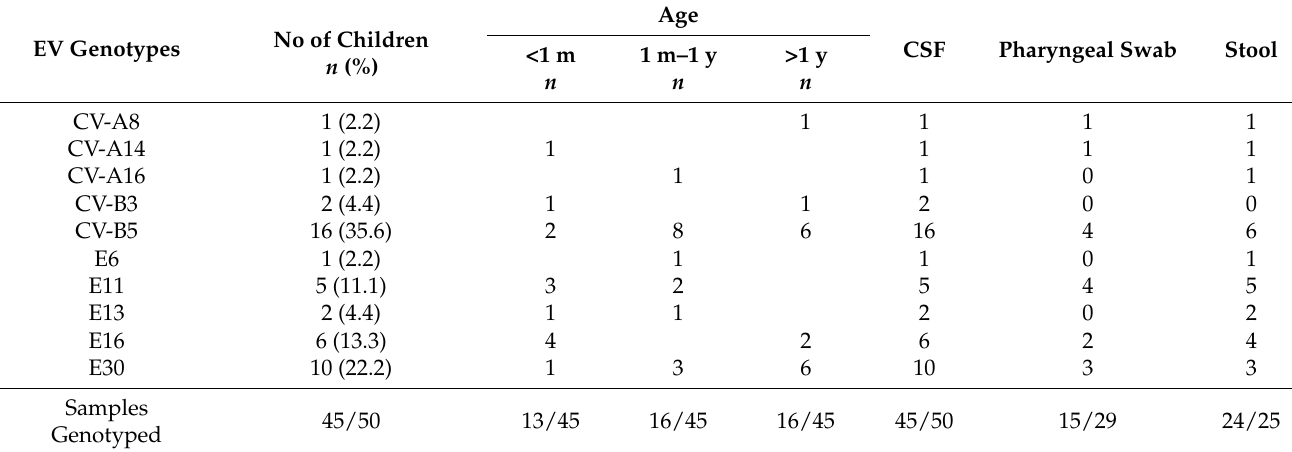
Table 1. Enteroviral (EV) genotype detection and age distribution in 84/104 different types of samples, from children with EV CNS infection ( n = 50). Ten different EV genotypes were detected during the study period (October